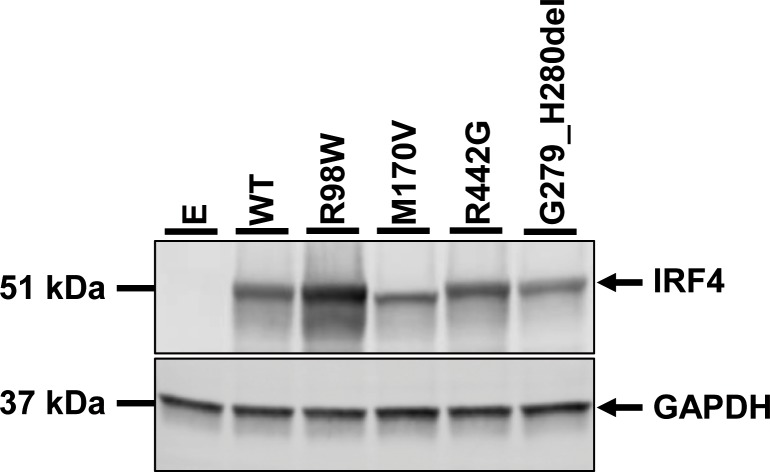
Protein levels of IRF4 variants from HGID database.HEK293T cells were transfected with the pcDNA3.1 empty vector (E), or plasmids encoding IRF4 WT, IRF4 R98W or IRF4 variants from the HGID database (see Figure 3). Total cell extracts were subjected to western blotting; the upper panel shows IRF4 levels and the lower panel shows the levels of GAPDH, used as a loading control. The results shown are representative of at least two independent experiments.